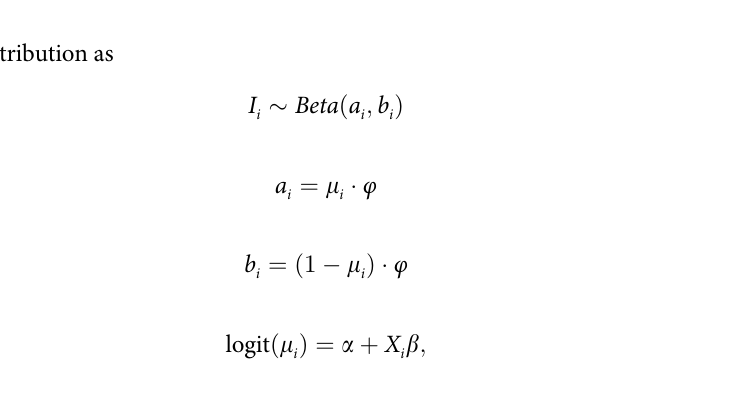
Fig 2. Maps of the geographic variables used to explain ignorance. The geographic variables used to explain ignorace (elevation, slope, road density, path density, population density and log population density) in Sweden at the 10 km grid cell resolution.